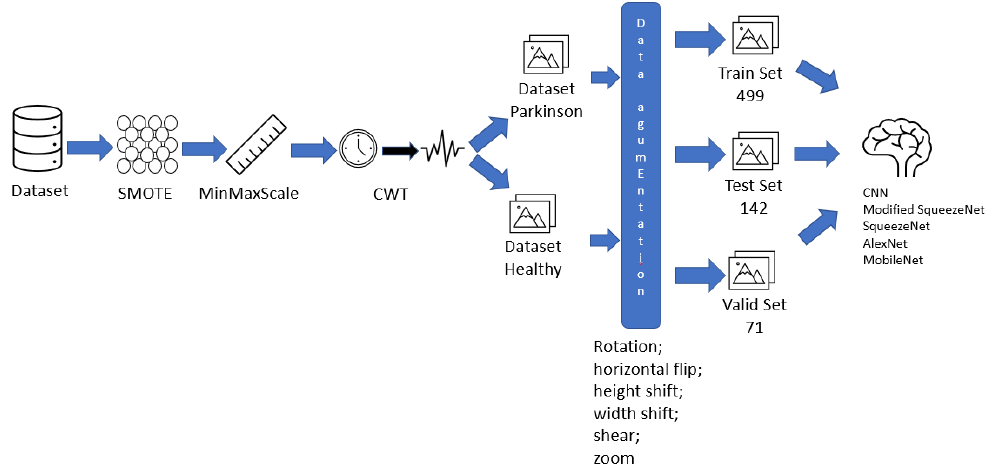
Figure 1. Fluxogram of the proposed